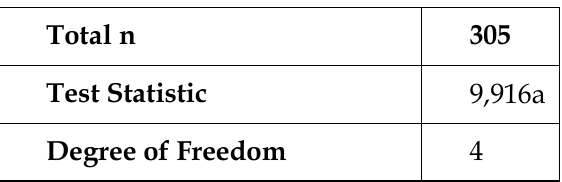
Table 19. Trust towards the health centre, and occupation. Kruskal-Wallis sig. test. The test statistic is adjusted for